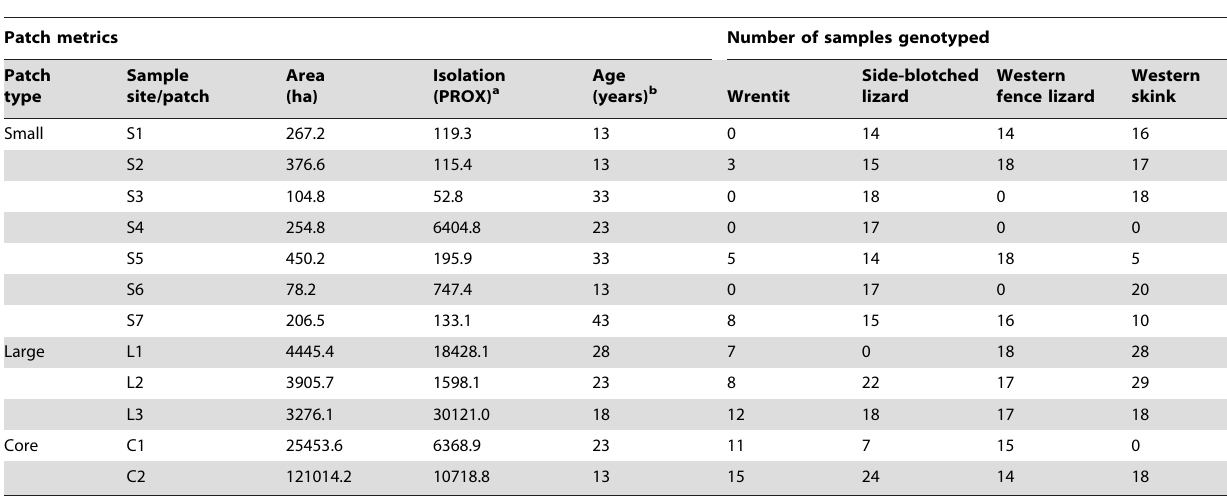
Table 1. Patch metrics (area, isolation, and age) and the number of samples genotyped by species.